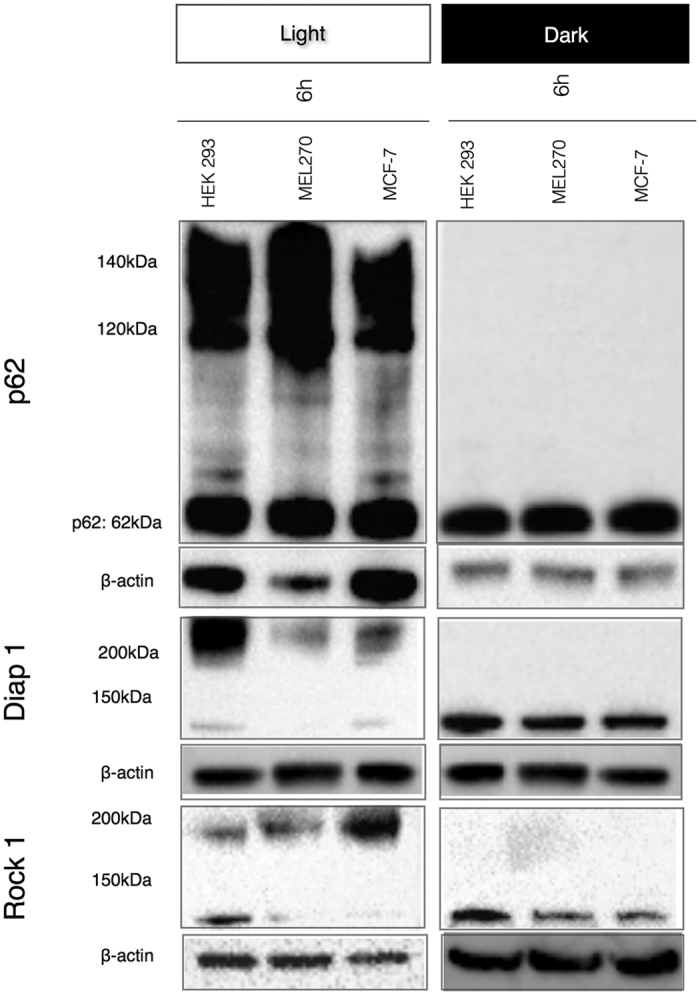
Cellular homogenates spiked with VP and incubated in ambient light exhibit formation of p62, Diap1, and Rock1 oligomers.Western-blot of protein extracts from cells never exposed to VP in culture but incubated (6hrs, room temperature) with 7.5 μg/ml Verteporfin post lysis either in absolute darkness (incubation and electrophoresis) or in light (incubation and electrophoresis). When incubation and electrophoresis were performed in absolute darkness there was no formation of high molecular weight complexes.